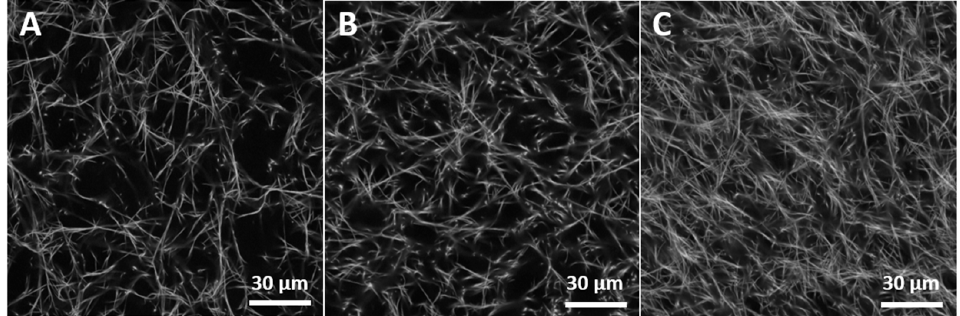
Figure 1. Structure and topology of collagen I matrices. ( A – C ): Characteristic Coll I network struc- ture for different Coll I concentrations (( A ): 1.5 mg/mL, ( B ): 2.0 mg/mL, ( C ): 2.5 mg/mL). Shown are laser-scanning images with a 40× magnification factor.